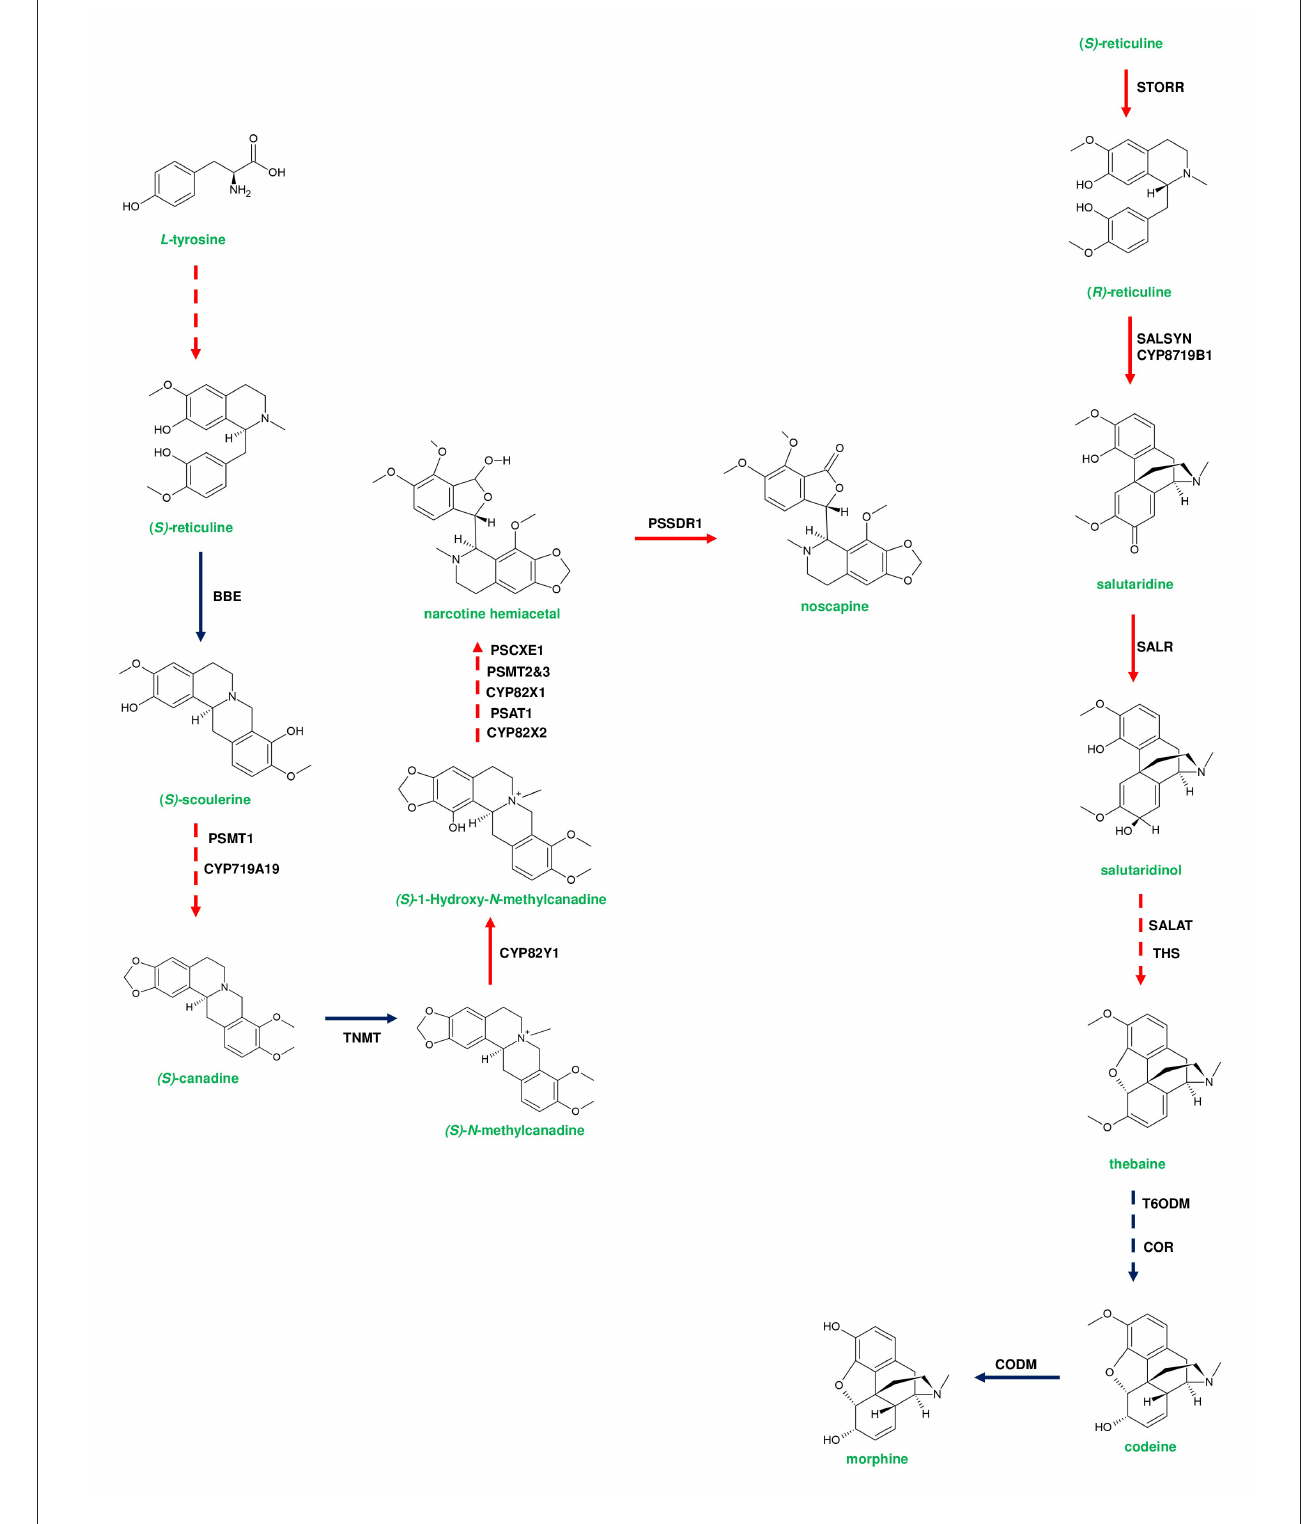
FIGURE 5 | Representative pathway showing the biosynthetic events of benzylisoquinoline alkaloids (BIAs) in Papaver somniferum . Genes responsible for (S) -reticuline biosynthesis from L-tyrosine are loosely clustered in the poppy genome. (S) -reticuline is converted to noscapine by a set of enzymes; berberine bridge